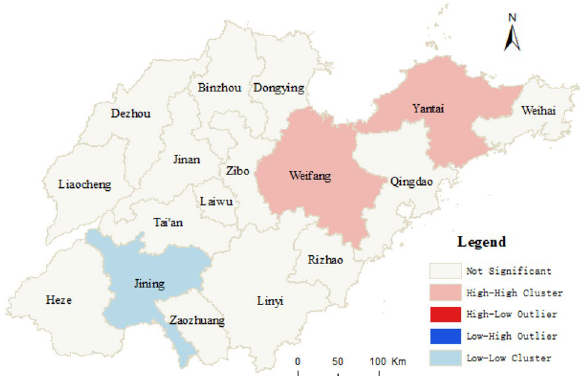
Figure 5. Spatial distribution of hot and cold spots of urban–rural integrated levels in Shandong province. High–High clustering (Low–Low clustering) indicates that the URI level of this city is high (low), and the URL level of its surrounding cities is also high (low); High–Low outlier (Low–High outlier) indicates that the URI level of this city is high (low), but the URL level of its surrounding cities is low (high); Not significant indicates that the local spatial autocorrelation of URI level is not significant. This figure was created with ArcGIS 10.5 (URL: http:// www. esri. com/).